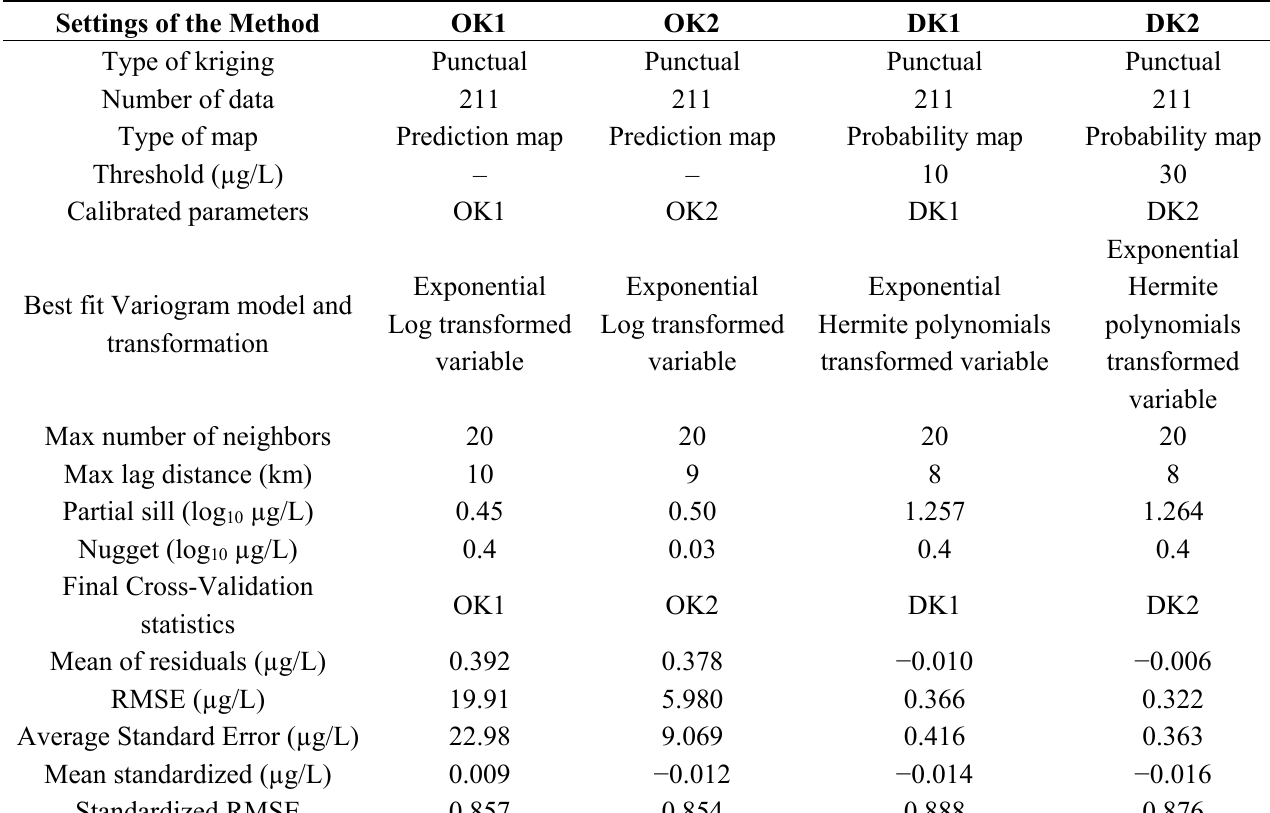
Figure 8. ( a ) Ordinary Kriging (OK1) of the entire basal aquifer dataset and cross-validation graph; and ( b ) Ordinary Kriging (OK2) with concentrations ≥ 30 µg/L grouped and cross-validation graph. Table 2. Summary of the Kriging settings and cross-validation